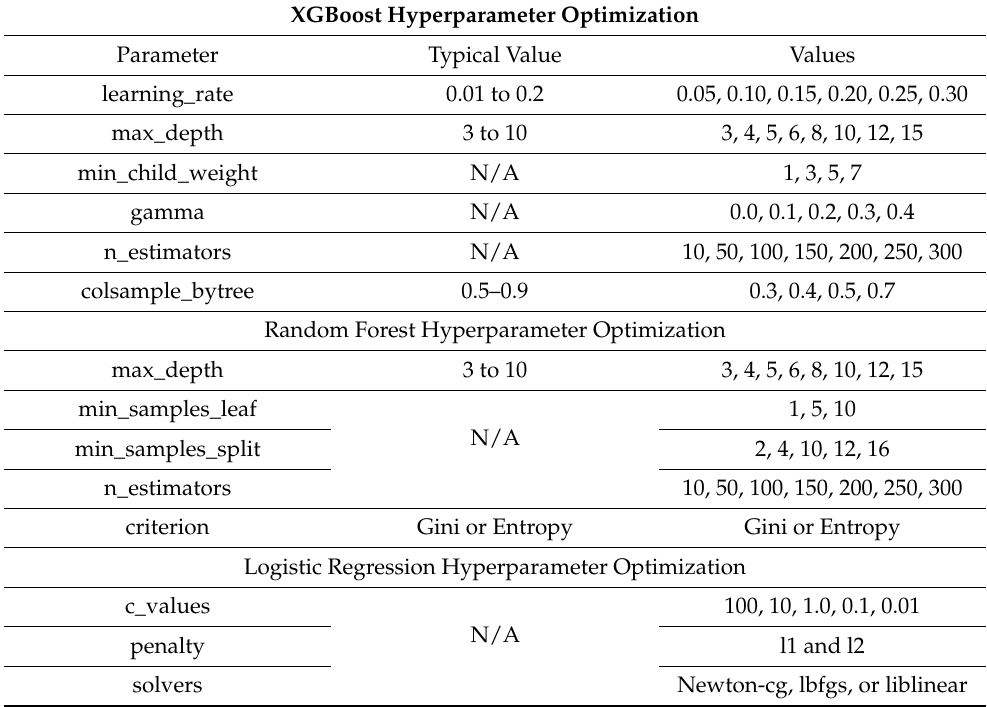
Table 2. Hyperparameter optimization off ML